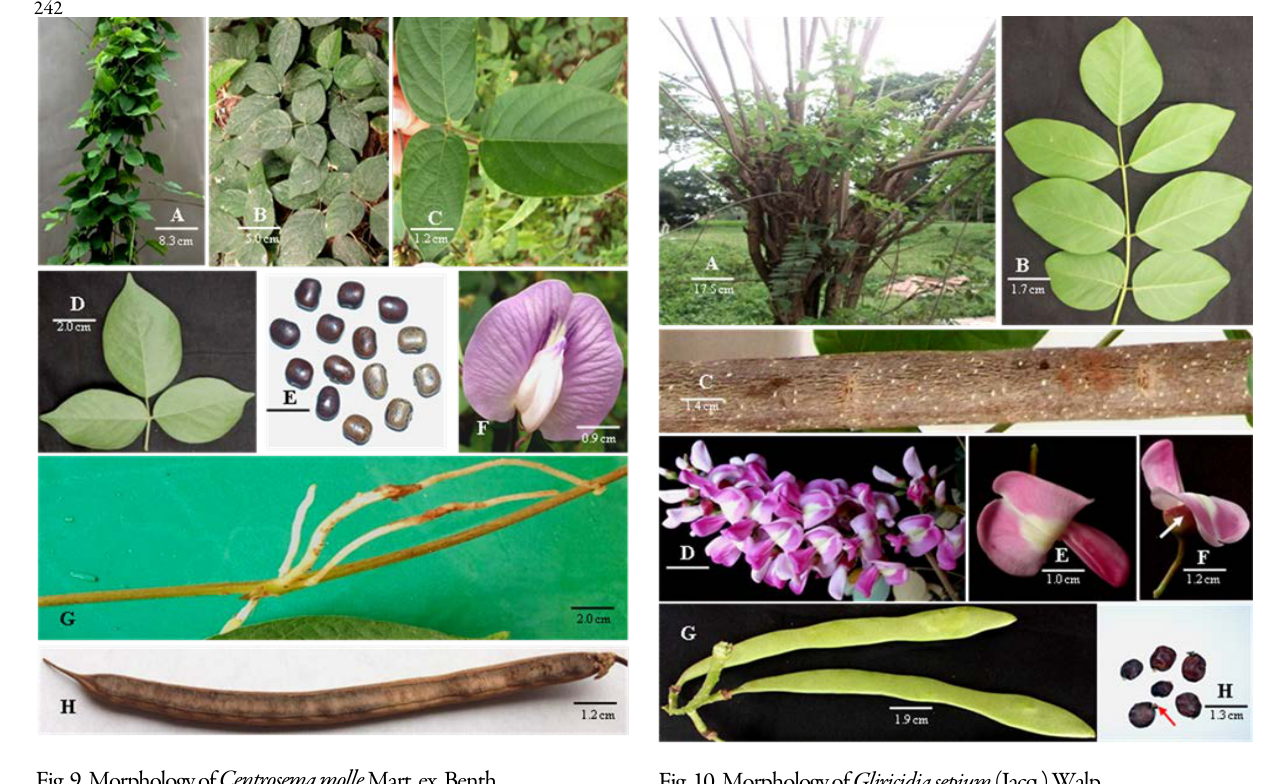
A. Habit (tree), B. Leaf, C. Stem, D. Inflorescence (terminal panicle), E and F. Flower (arrow pointing at the calyx), G. Fruit (fresh), H. Seeds (arrow pointing at prominent hilum